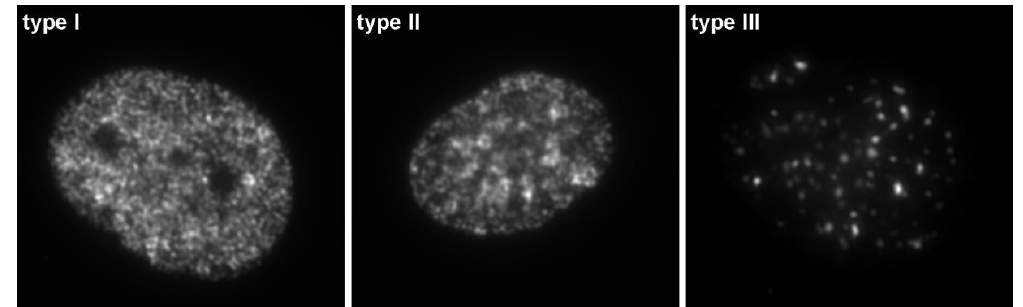
Figure 3. Three replication patterns visualized by BrdU immuno-detection during the S phase. The HeLa cells were labeled with BrdU for 10 min, fixed (2% formaldehyde, 10 min), permeabilized (0.2% Triton X-100, 10 min), and treated with 4N HCl (20 min). The incorporated BrdU was visualized using anti-BrdU antibody and Cy3 labeled anti-mouse antibody. Type I —large number of small replication sites characteristic for early S phase; type II —replication sites concentrated at the periphery of the nucleus and nucleoli (mid S phase); type III —large replication sites over heterochromatin (late S phase).